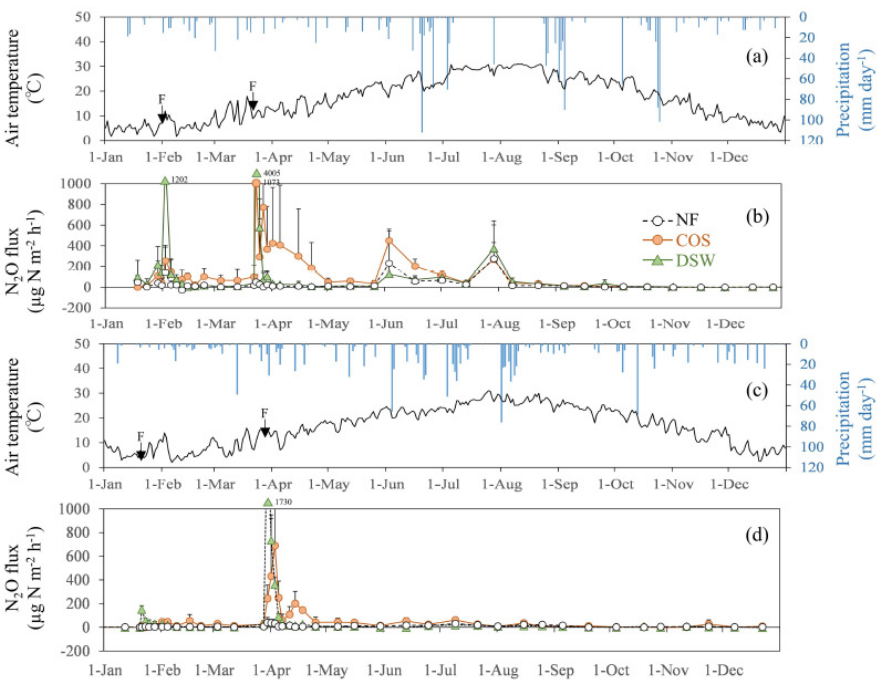
Figure 1. Seasonal variation in air temperature and precipitation in 2013 ( a ); and 2014 ( c ); soil N 2 O fluxes in 2013 ( b ); and 2014 ( d ) in no fertilizer (NF), combined organic and synthetic fertilizer (COS), and distilled silage waste (DSW) treatments in a citrus orchard in southwestern Japan. Error bars represent standard deviations. F denotes fertilization.